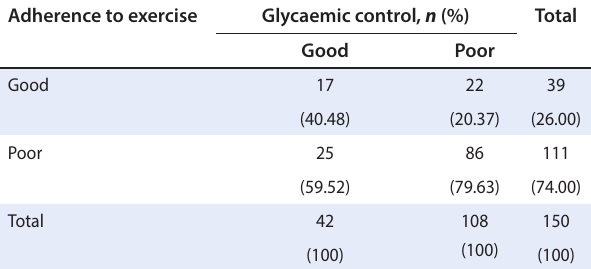
Table 3: Association between adherence to exercise and glycaemic control